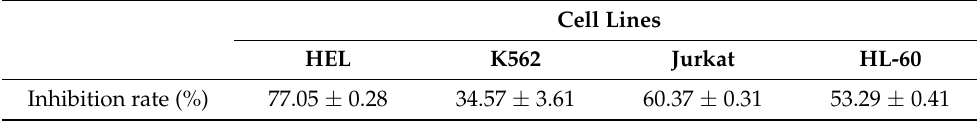
Table 1. The effect of ZH-254 on the growth of leukemic cells. Cell Lines HEL K562 Jurkat HL-60 Inhibition rate (%) 77.05 ± 0.28 34.57 ± 3.61 60.37 ± 0.31 53.29 ±